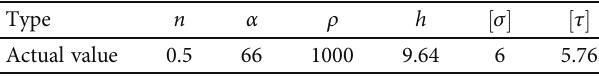
Figure 11: Part of the right geophysical map of the Wulaofeng Tunnel. Table 9: Other data of Wulaofeng Tunnel